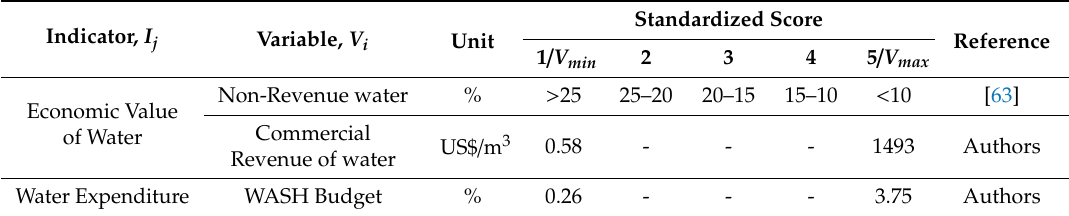
Table 4. Benchmarking variables for water economy dimension.